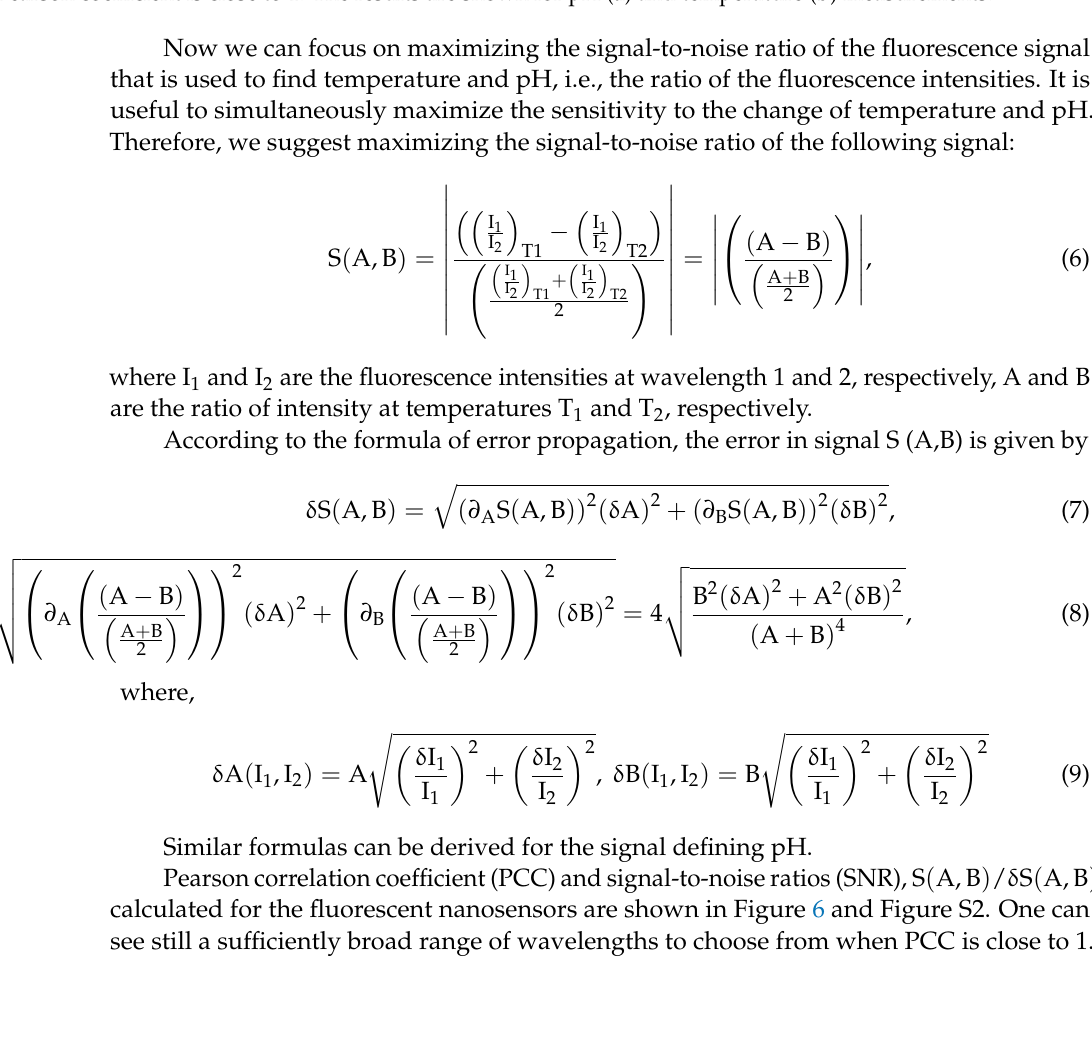
Figure 5. The Pearson correlation coefficients are shown for different wavelengths used to calculate the ratio of fluorescent intensities. The dependence between the model parameters (temperature and pH) and the corresponding ratios is close to linear when the Pearson coefficient is close to 1. The results are shown for pH ( a ) and temperature ( b ) measurements.